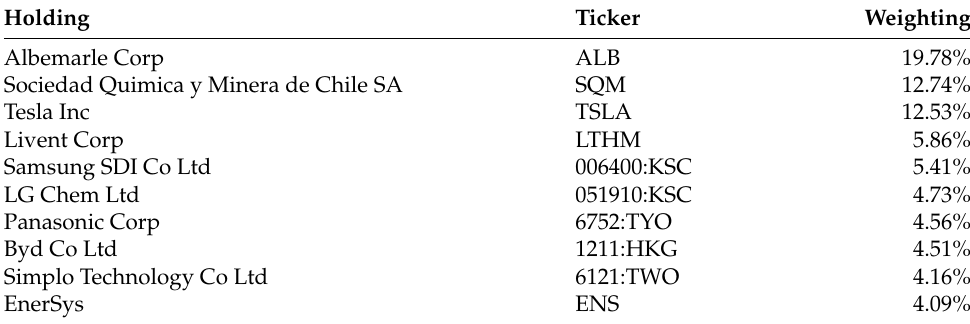
Table A2. Global X Lithium (LIT) holdings. Holding Ticker Weighting Albemarle Corp